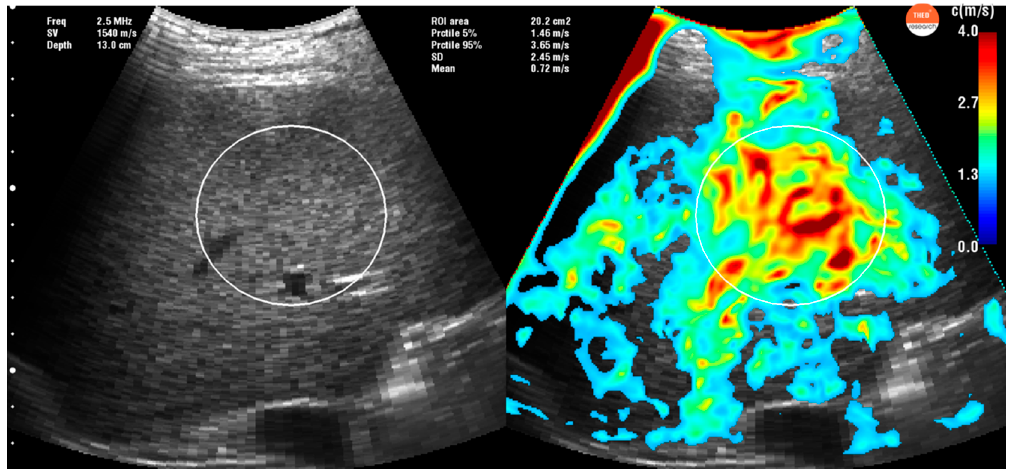
Figure 2. Liver stiffness measurement obtained with THE-Time Harmonic Elastography in a cirrhotic patient. In this picture, we can see the wide liver approach thru the intercostal section and the acquisition of the liver stiffness measurement (in the right side of the figure) reflecting cirrhotic liver in orange-red. ROI is selected in the most homogeneous area. The current region of interest has an area of 20.2 cm 2 with a corresponding liver stiffness (mean ± SD, (5% percentile, 95% percentile)) of shear wave speed = 2.45 m/s ± 0.72 m/s (1.46 m/s, 3.65 m/s) and Young’s modulus = 18.01 kPa ± 10.58 kPa (6.39 kPa, 39.97 kPa), respectively.